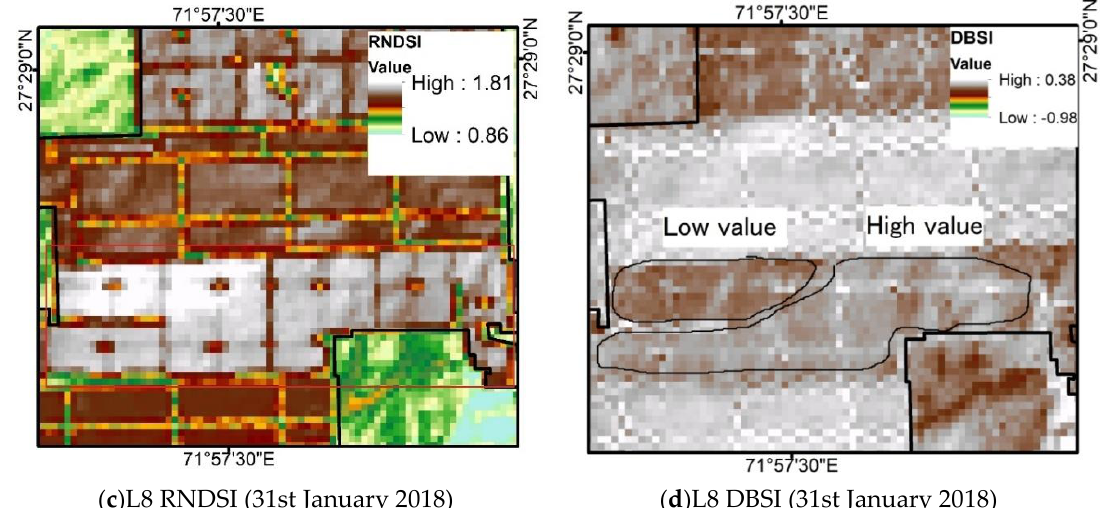
Figure 13. Comparison of ( b ) NDSI, ( c ) RNDSI and ( d ) DBSI with ( a ) high-resolution red, green, blue (RGB) PlanetScope data. The bright patches on panels created by sand deposition are highlighted by high value on NDSI, RNDSI and DBSI results.